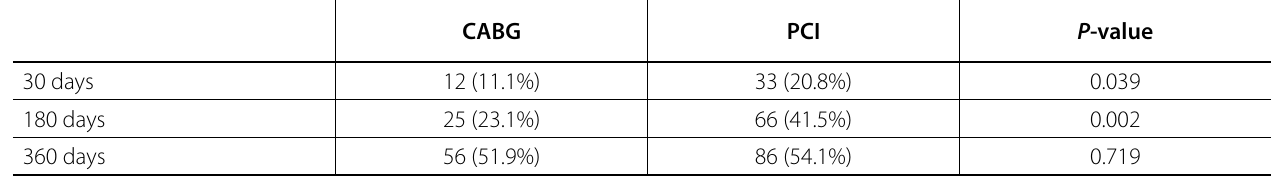
Table 2. Relapse to smoking in patients undergoing surgical revascularization (CABG) or percutaneous intervention (PCI).